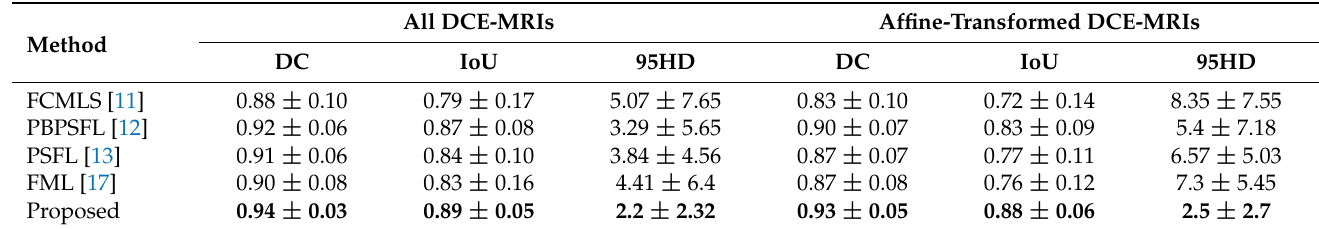
Table 1. Performance comparison of the proposed approach and recent LSet-based